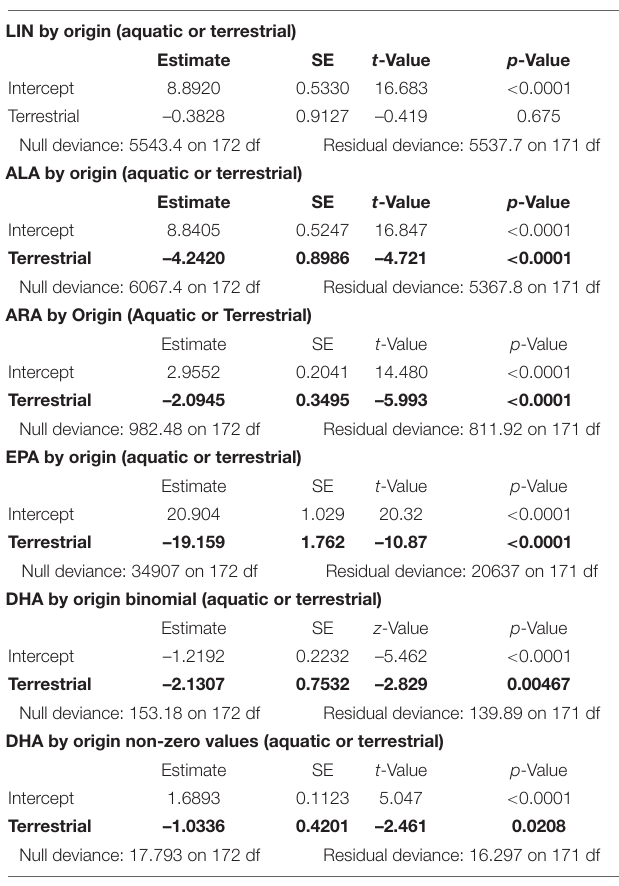
TABLE 1 | General linear models of fatty acid content by arthropod habitat